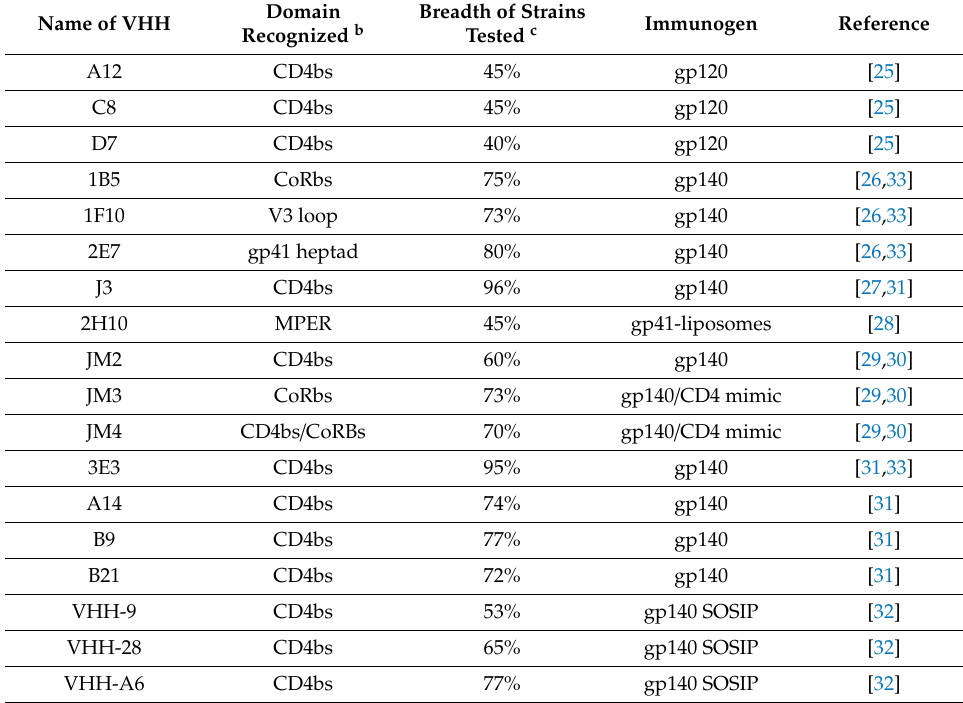
Table 1. Nanobodies with broad neutralizing activity for HIV-1 a